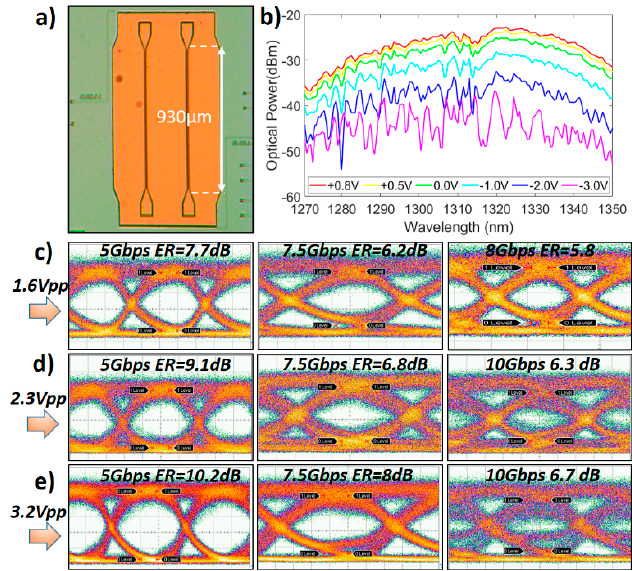
Figure 16. ( a ) An optical micrograph of the push-pull modulator and ( b ) DC characterization results. The extinction ratio is >10 dB across 1270-1350 nm range and NRZ OOK eyes diagrams with ( c ) 1.6 V pp , ( d ) 2.3 V pp and ( e ) 3.2 V pp in a differential driving scheme (the drive voltage applied on each arm).